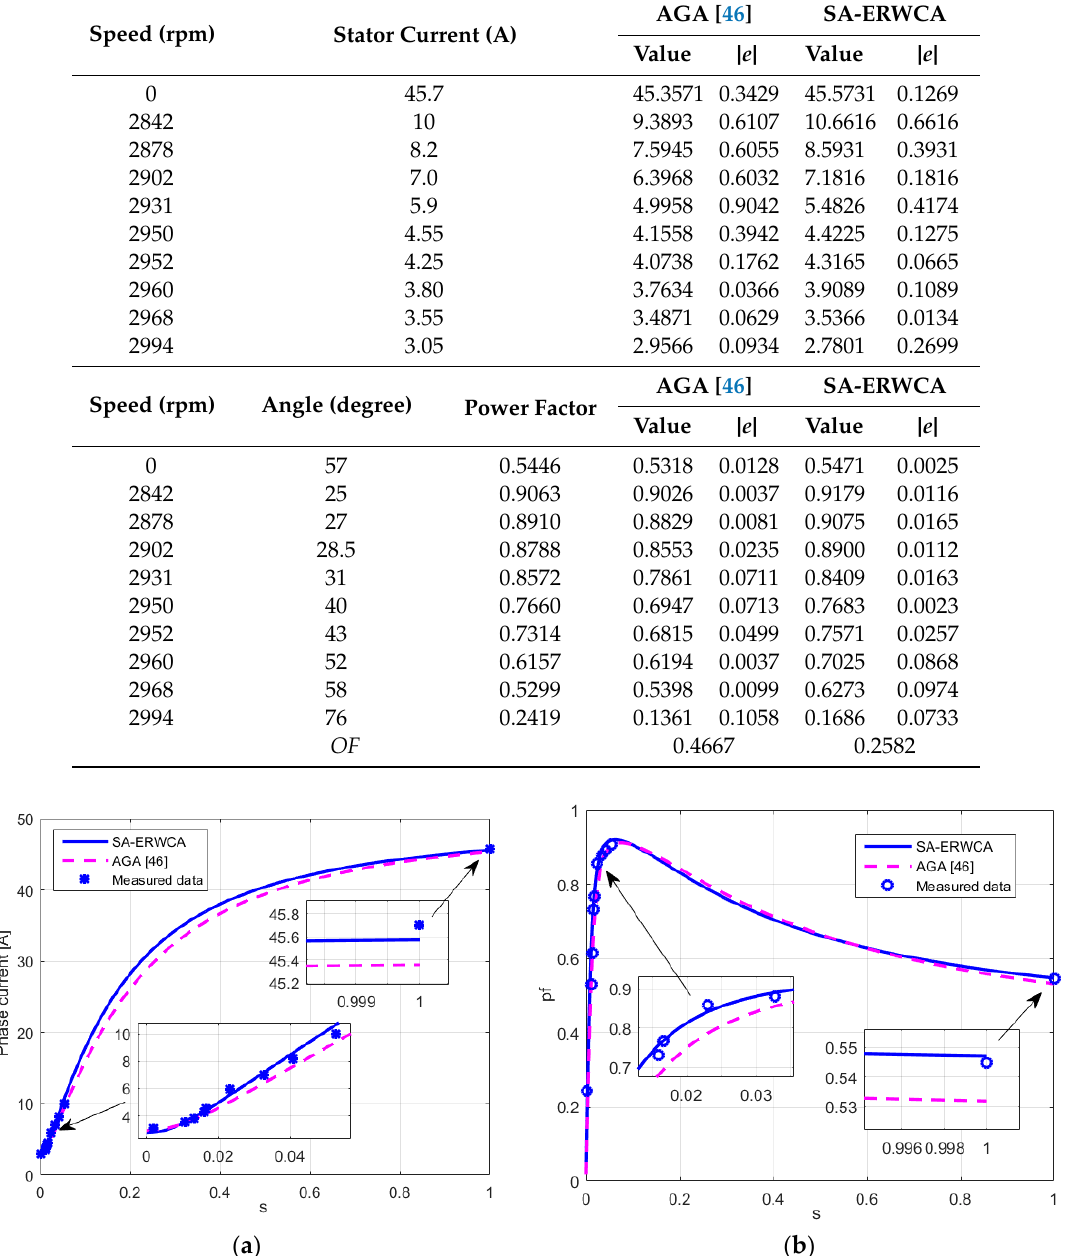
Table 23. Comparison of AGA and SA-ERWCA results with measured data for Machine 5.